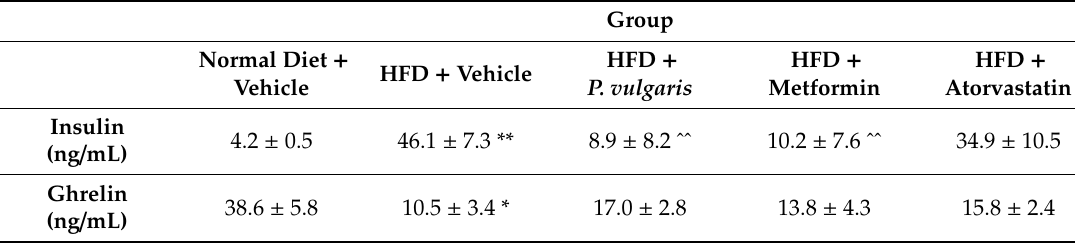
Table 2. Insulin and ghrelin